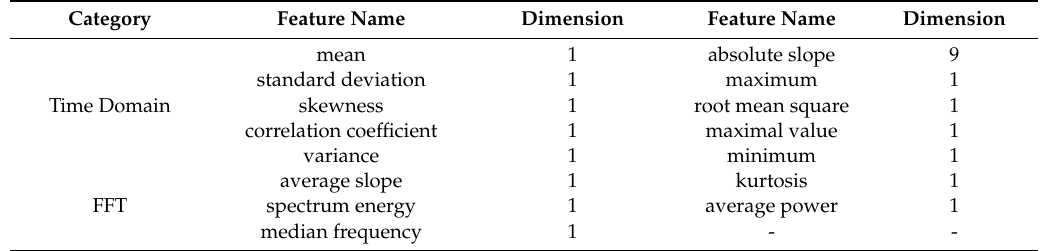
Table 2. Feature name and corresponding dimension table. FFT: Fast Fourier